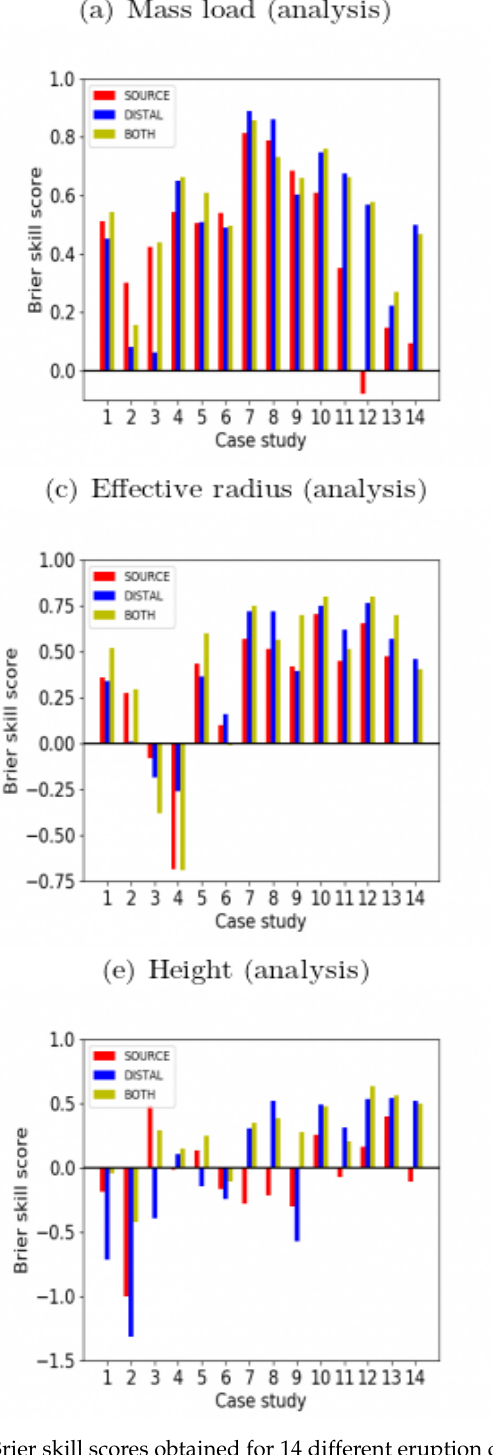
Figure 3. Brier skill scores obtained for 14 different eruption case studies using detection-based initialization and optimization: ( a ) Mass load analyses, ( b ) mass load forecasts, ( c ) effective radius analyses, ( d ) effective radius forecasts, ( e ) cloud top height analyses, and ( f ) cloud top height forecasts. Note that, even though only the detections are used for initialization and optimization, the full VOLCAT retrievals are used to compute the Brier skill scores here. The case studies numbered 1 to 14 are described in more detail in Section 3 and in Zidikheri and Lucas (2020). They are (1) Kelut, (2) Sangeang Api I, (3) Manam I, (4) Tinakula, (5) Sangeang Api II, (6) Manam II, (7) Soputan I, (8) Soputan II, (9) Sangeang Api III, (10) Merapi, (11) Rinjani III, (12) Agung, (13) Rinjani I, and (14) Rinjani II; the roman numerals indicate the time